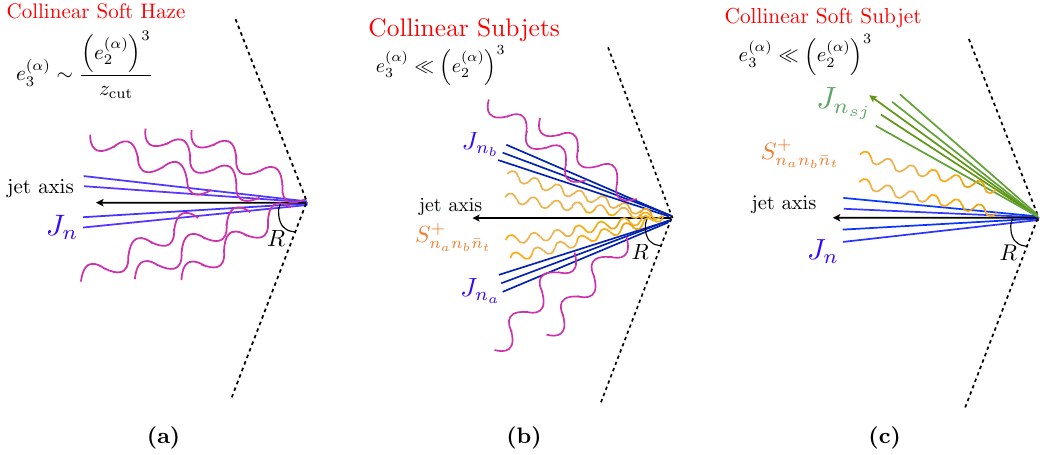
Figure 5. Regions of interest for studying the two-prong substructure of a jet on which the soft drop grooming algorithm has been applied. (a) Collinear-soft haze region in which no subjets are resolved. (b) Collinear subjets with comparable energy and a small opening angle. (c) Collinear-soft subjet carrying a small fraction of the total energy, with z cs